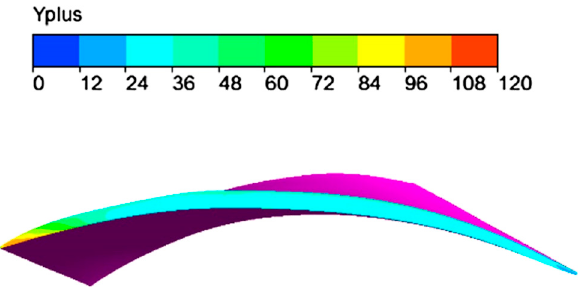
Figure 5. y+ of the blade tip region.